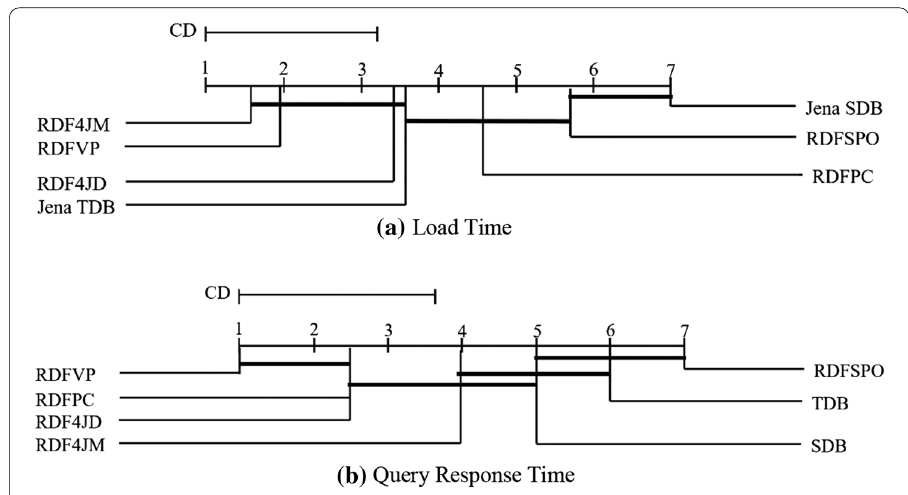
Fig. 10 Computational performance comparison of the proposed RDFVP, RDFSPO and RDFPC against the existing methods with Nemenyi Test. a Load time, b query response